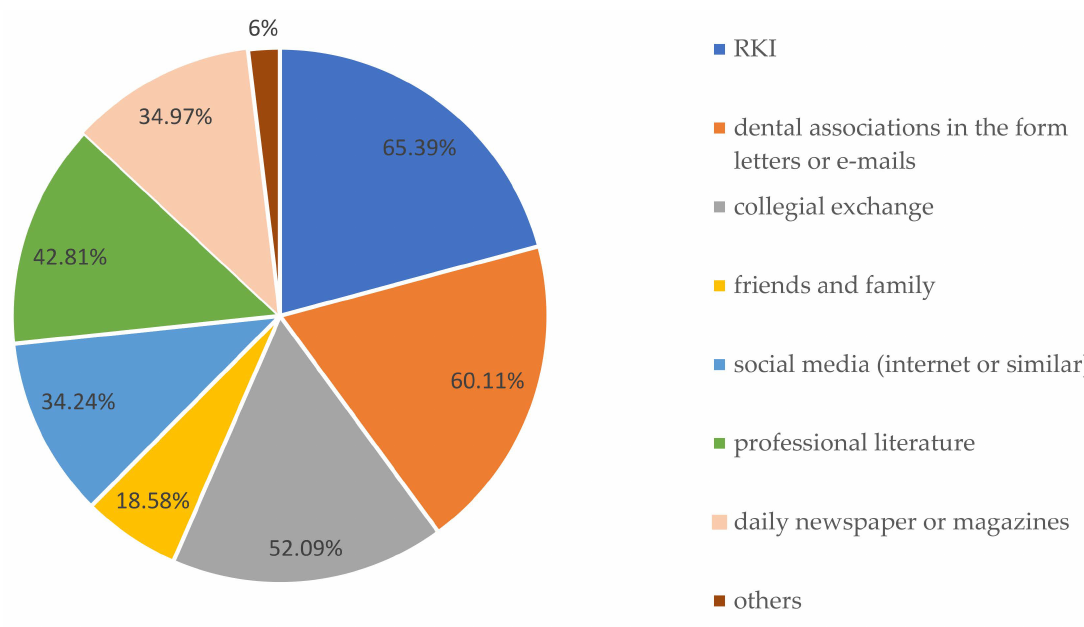
Figure 1. Number ( n ) and type of postponed measures with reasons for cancelled appointments.